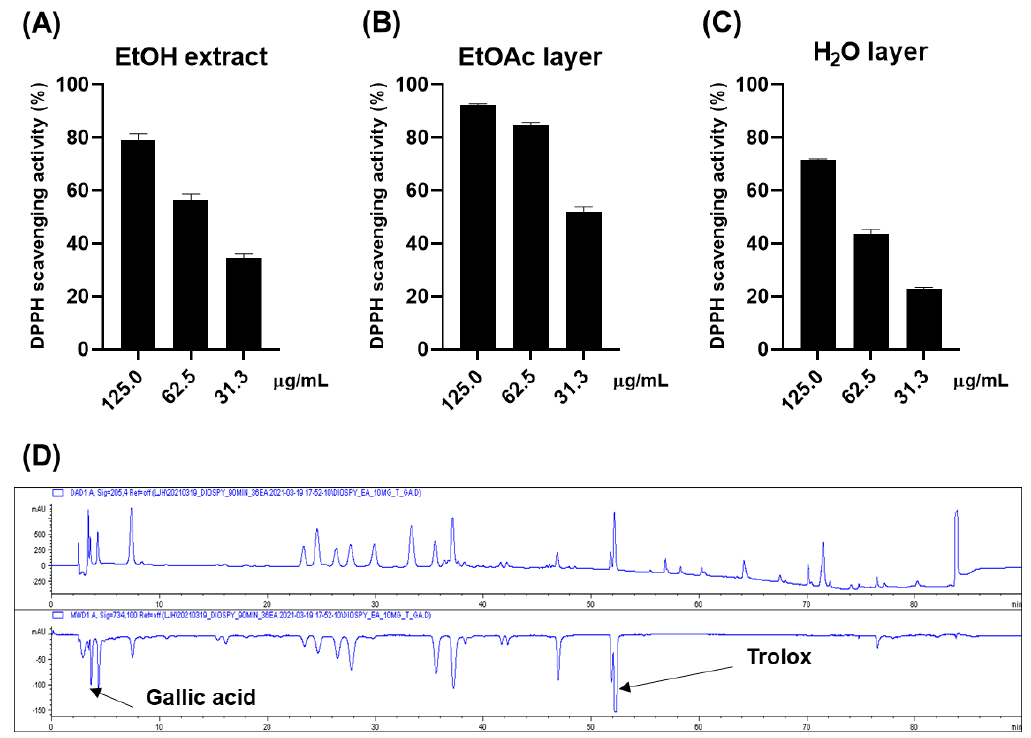
Figure 1. DPPH scavenging effects of the EtOH extract ( A ), EtOAc layer ( B ), and H 2 O layer ( C ) H 2 O layer of the persimmon leaves; ( D ) online ABTS-HPLC chromatogram of the EtOH extract.